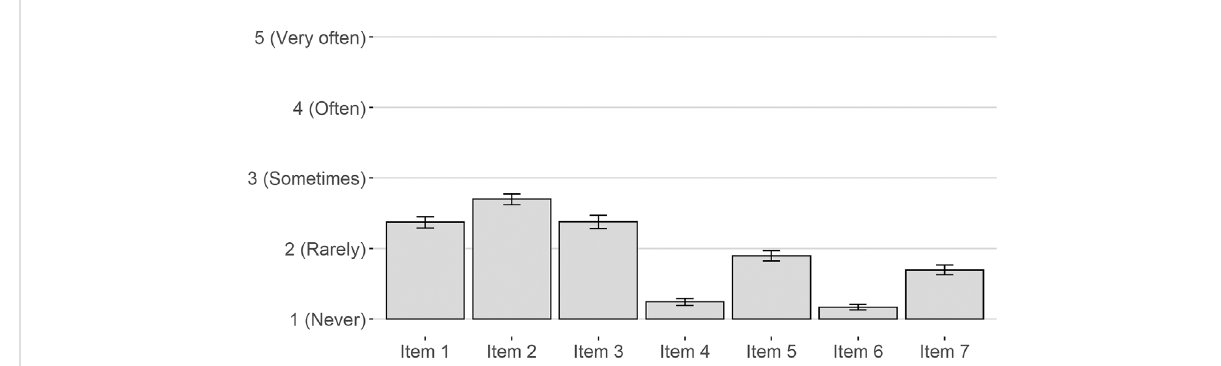
FIGURE 1 Means of the individual items in the GAS-7. Notes. The wording of the items (and the symptoms they refer to, in brackets)were as follows: Item 1 — Did you think about using VR all day long? [Salience]; Item 2 — Did you spend increasing amounts of time in VR? [Tolerance]; Item 3 — Did you use VR to forget about real life? [Mood modi fi cation]; Item 4 — Have others unsuccessfully tried to reduce your VR use? [Relapse]; Item 5 — Have you felt bad when you were unable to use VR? [Withdrawal]; Item 6 — Did you have fi ghts with others (e.g., family, friends) over your time spent in VR? [Con fl ict]; Item 7 — Have you neglected other important activities (e.g., school, work, sports) to use VRs? [Problems]. Error bars represent the 95% con fi dence interval.